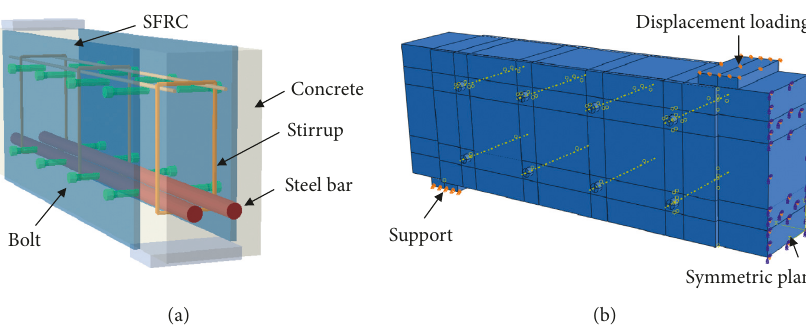
Figure 13: FE model. (a) FE model of 1.5F-8D12. (b) Loading and boundary condition.